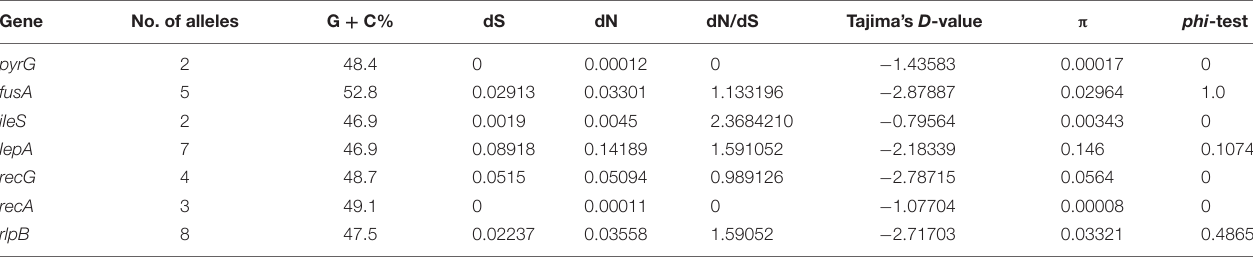
TABLE 3 | MLST allele sequence information and diversity.